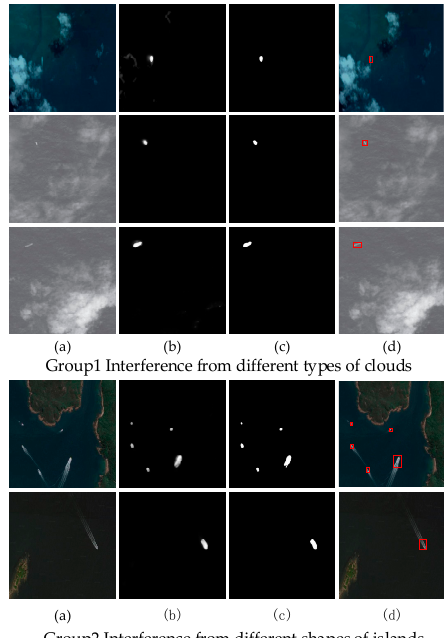
Figure 5. Candidate region detection results in complex backgrounds. Group1 consists of images interfered by the cloud cover and group 2 consists of images interfered by islands. ( a ) Test image. ( b ) Saliency map generated by our visual attention model. ( c ) Image segmentation with Otsu algorithm. ( d ) Candidate region detection results.